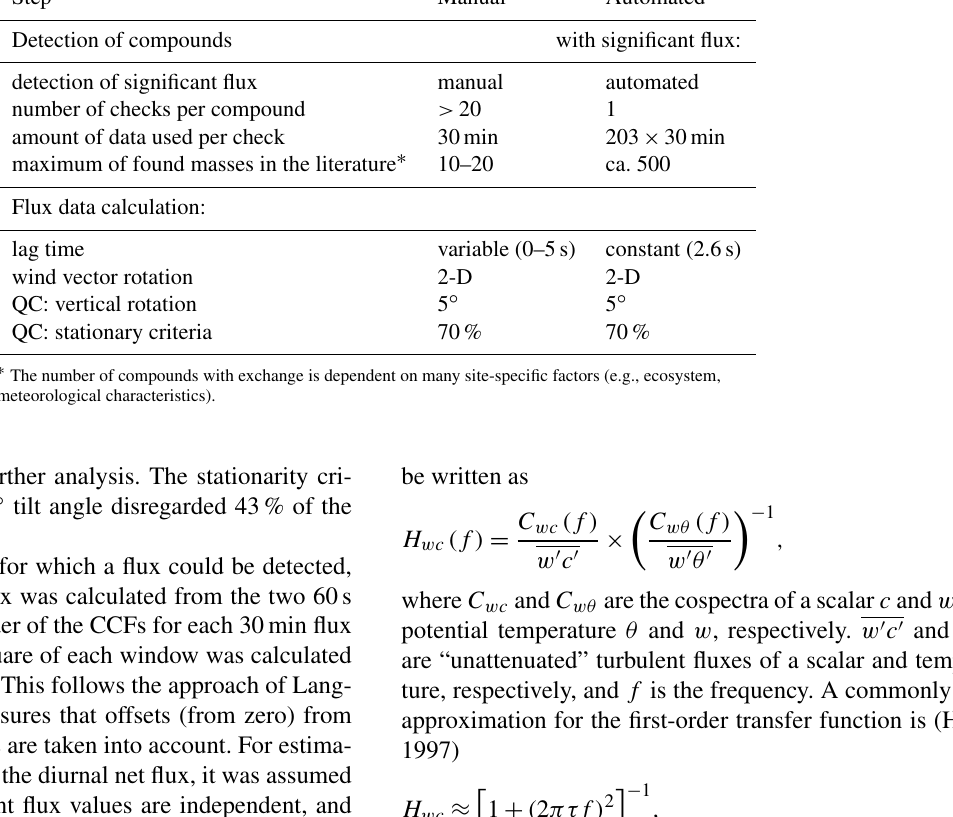
Table 1. Comparison between the manual and the automated method for calculating VOC fluxes. QC means quality criteria and 203 is the number of 30min periods measured between 10:00 and 16:00. Step Manual Automated Detection of compounds with significant flux: detection of significant flux manual automated number of checks per compound > 20 1 amount of data used per check 30min 203 × 30min maximum of found masses in the literature ∗ 10–20 ca. 500 Flux data calculation: variable (0–5s) constant